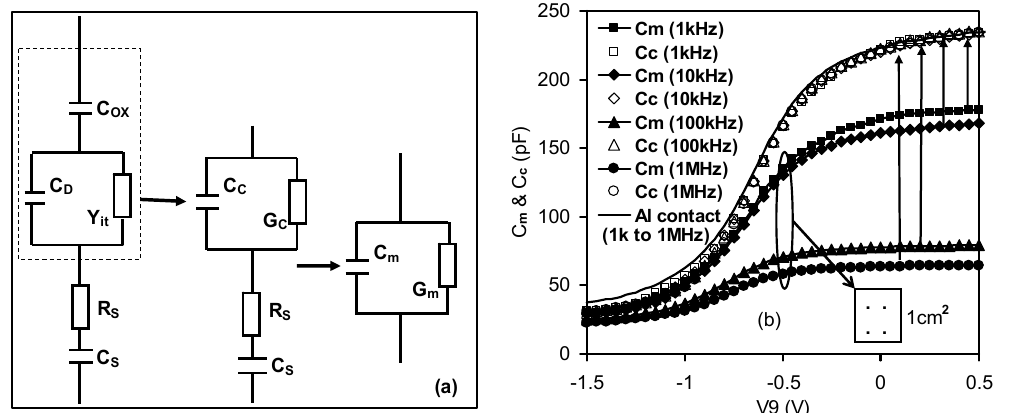
Figure 8. Effects of series resistance and back contact imperfection. ( a ) Equivalent circuit model, taking into account the presence of parasitic components from series resistance, and R ). C is the cables and back contact imperfection (with the addition of the C S S D depletion capacitance of silicon and Y is the admittance due to the interface states it between SiO and silicon substrate, respectively. C is the oxide capacitance; ( b ) Extracted 2 ox -Vg curves based on measured data C and G using Equation (2). Dispersions C C m m disappear after considering C and R or depositing back Al contact (solid line). The blank S S square shows the tested device without back Al contact on silicon substrate. The effective substrate area is 1cm 2